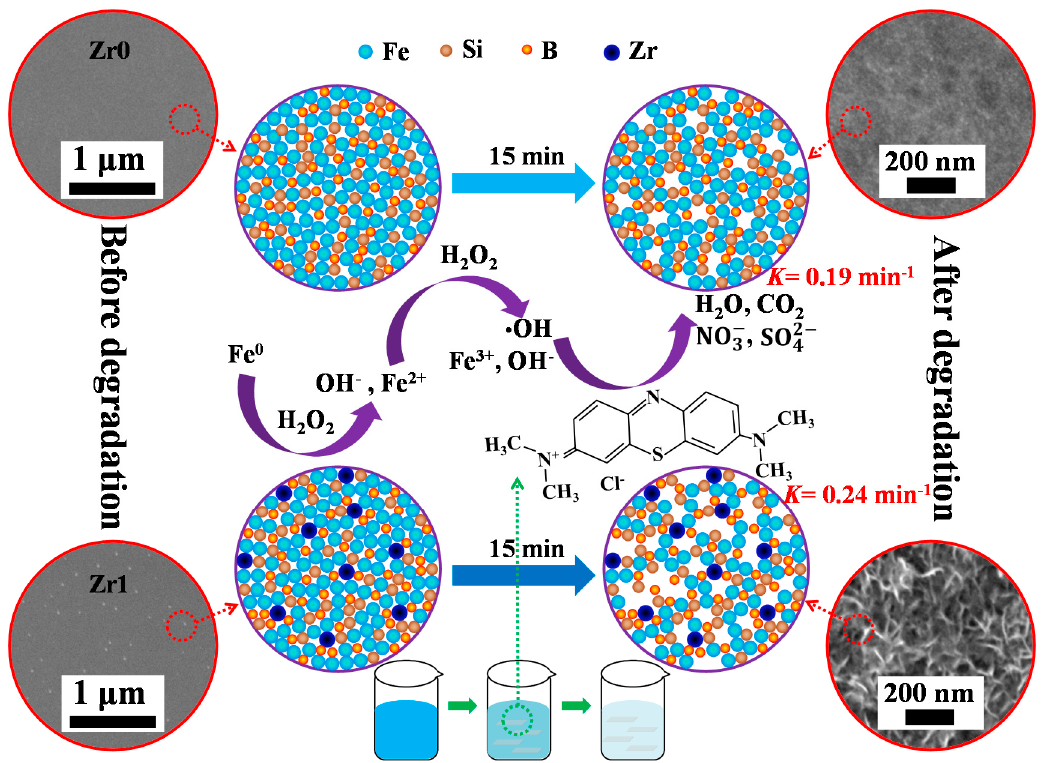
Figure 9. Schematic diagrams of the pathway of MB solution degradation in Fenton-like reaction using the Zr0 and Zr1 amorphous ribbons.